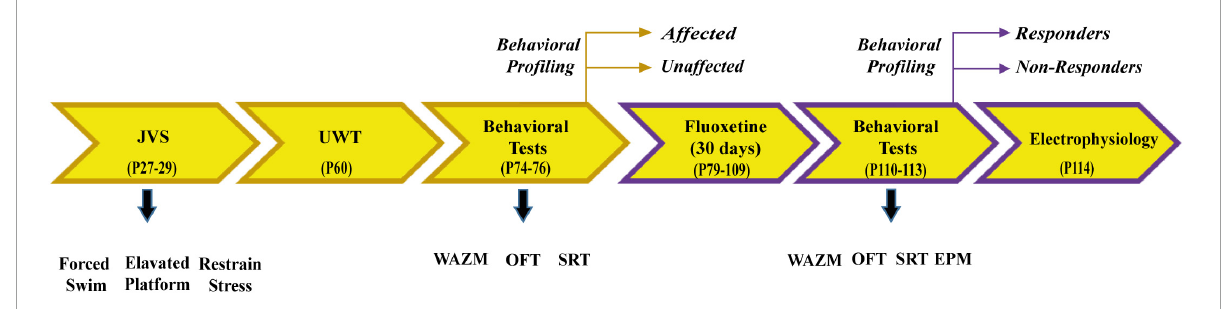
FIGURE2 Schematic representation of experimental paradigm